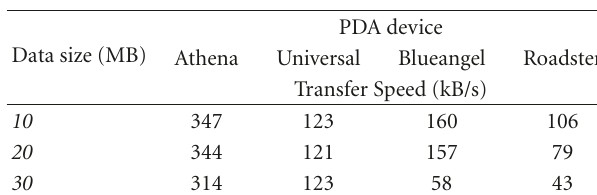
Table 1: Data transfer tests—PDA is connected through WiFi infrastructure—use of internal FLASH ROM memory.